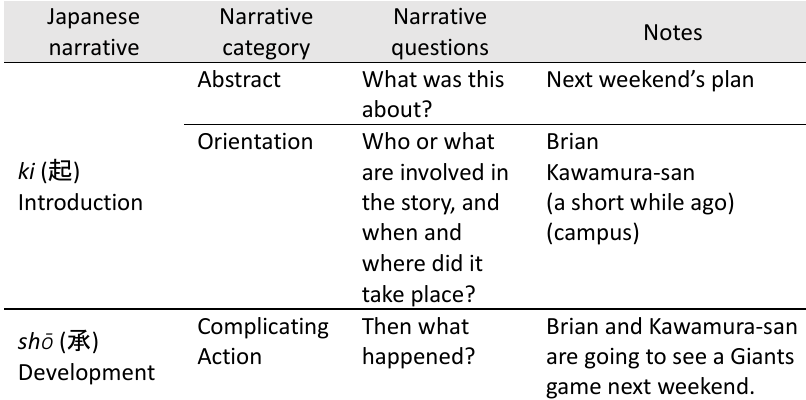
Table 3. Notes for narrative production about the dialogue from NihonGO